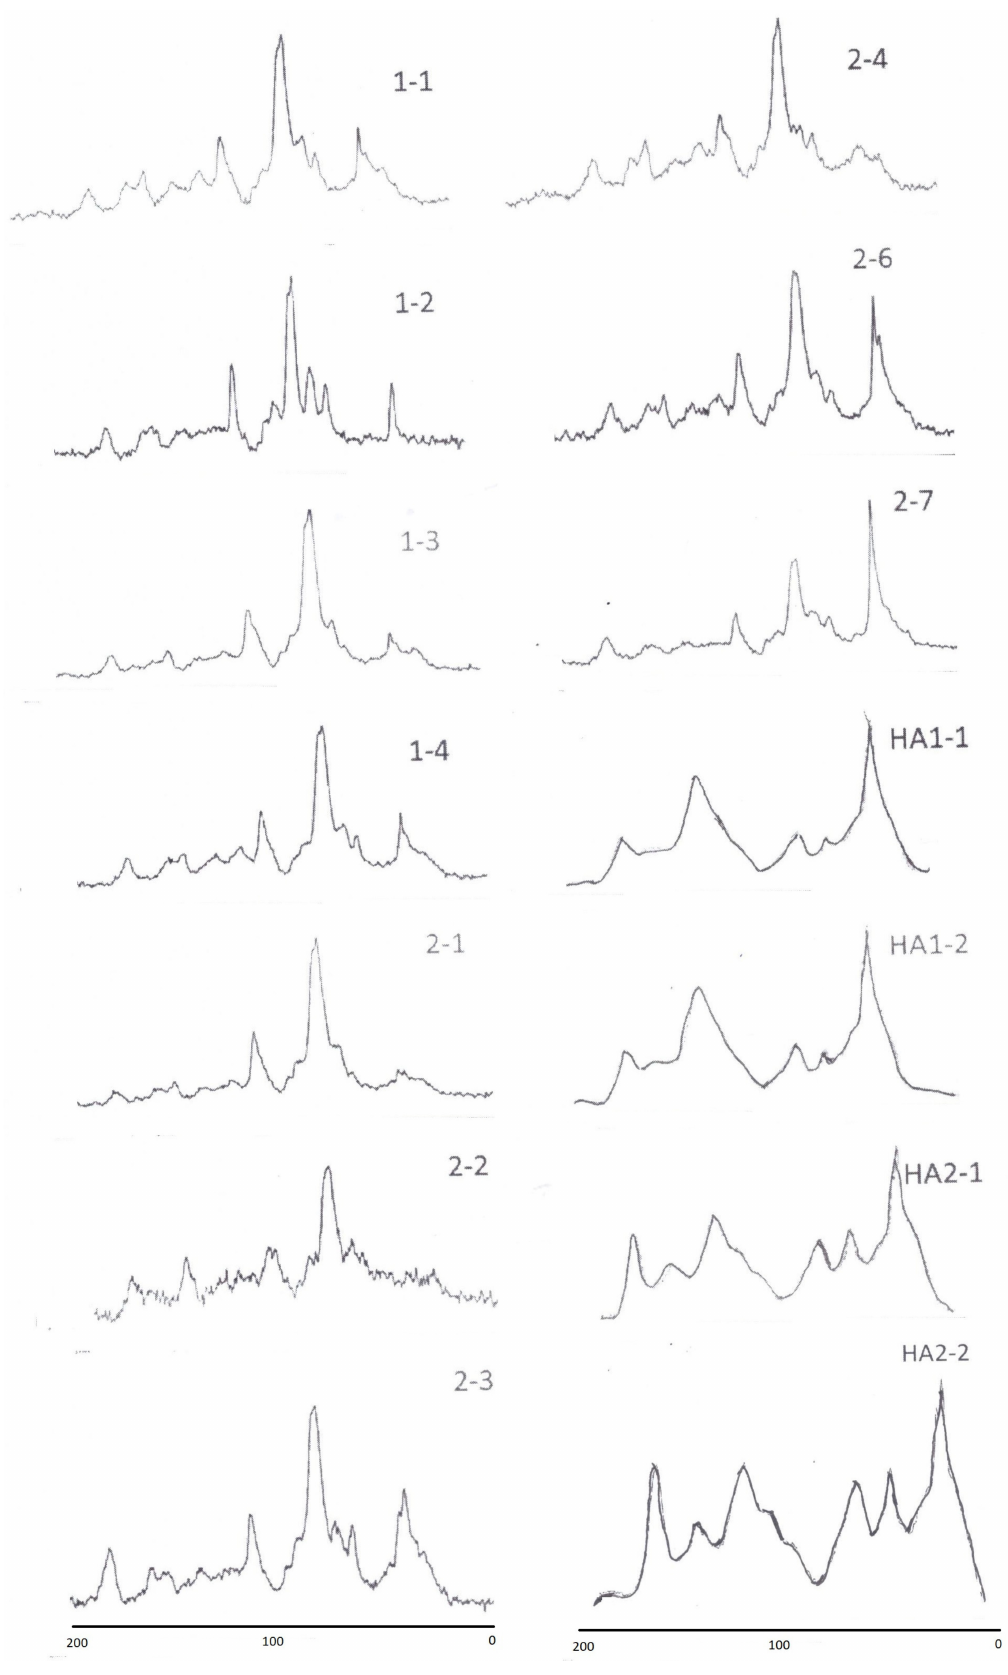
Figure 6. 13-C spectra of investigated organic materials (x-axis—chemical shift,